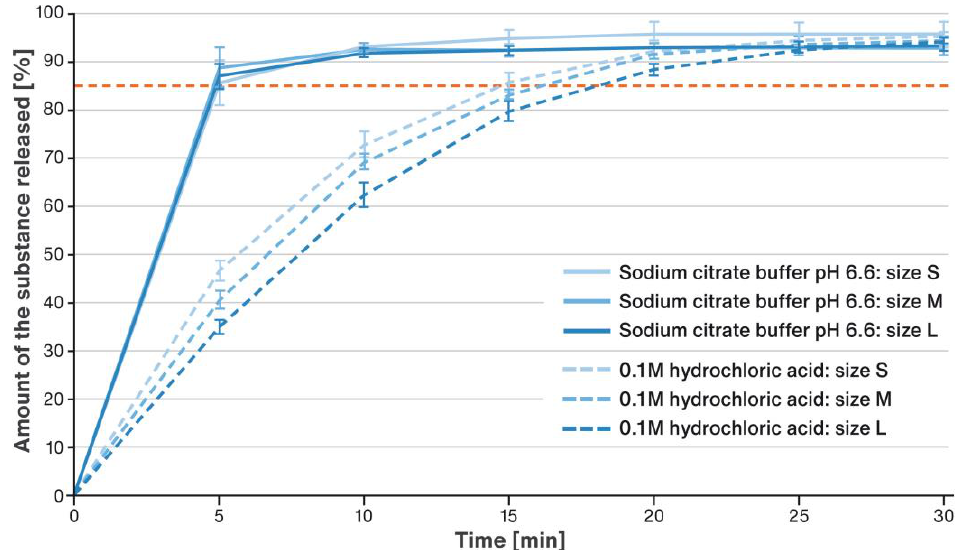
Figure 4. Comparison of the dissolution rate of RSC from a 5 mg sprinkle multiparticulates in 0.05 M sodium citrate buffer pH 6.6 (solid line) and 0.1 M HCl (dotted line); mean values of n = 6, SD is indicated by the error bars.